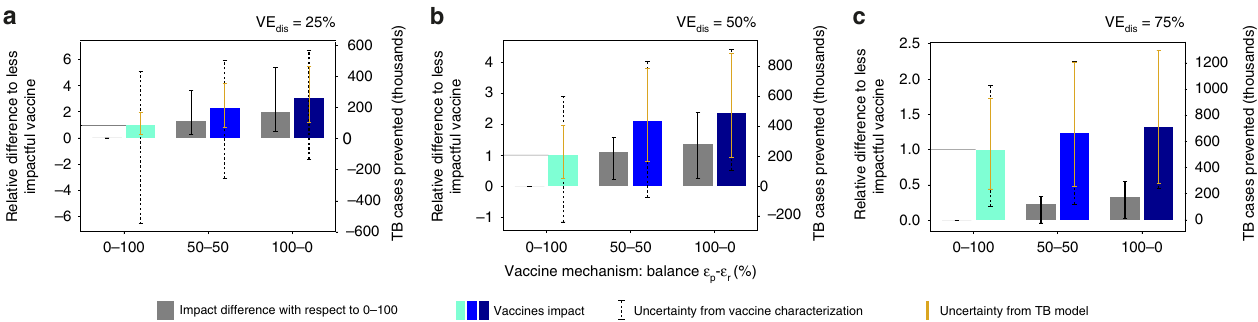
Fig. 3 Impact evaluation of empirically characterized vaccines: mechanism effects on expected impact and uncertainty. a , b , c Vaccines characterized from an ef fi cacy readout of VE dis ¼ 25 % , VE dis ¼ 50 % and VE dis ¼ 75 % , respectively. Blue bars: impact estimates for different vaccines. Two different contributions to the overall impact uncertainty are distinguished: Gold bars: intrinsic contribution coming from general inputs of the transmission model. Black, dashed bars: extra contribution from uncertain vaccine characterizations. Grey bars: differences in impact between each vaccine and the least impactful case of a vaccine acting 100% through ε (leftmost, light blue bar in each panel). Error bars represent the 95% con fi dence p ¼ 0 : 25, and 32% (95% CI: 2.5 – 55%) for CI: 52 – 541%) for VE dis ¼ 0 : 75, with respect to the vaccine acting through ε VE ). dis r